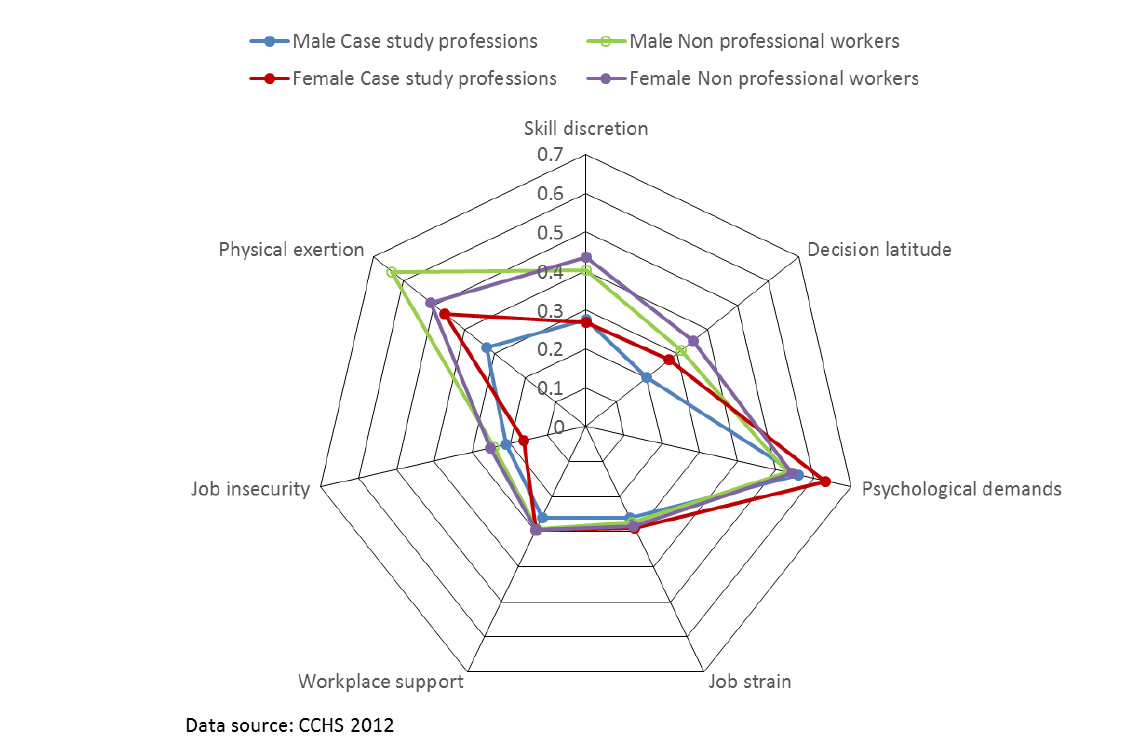
Figure 3. Compared to men, women workers in case study professions showed a higher job strain, physical exertion, and lower job